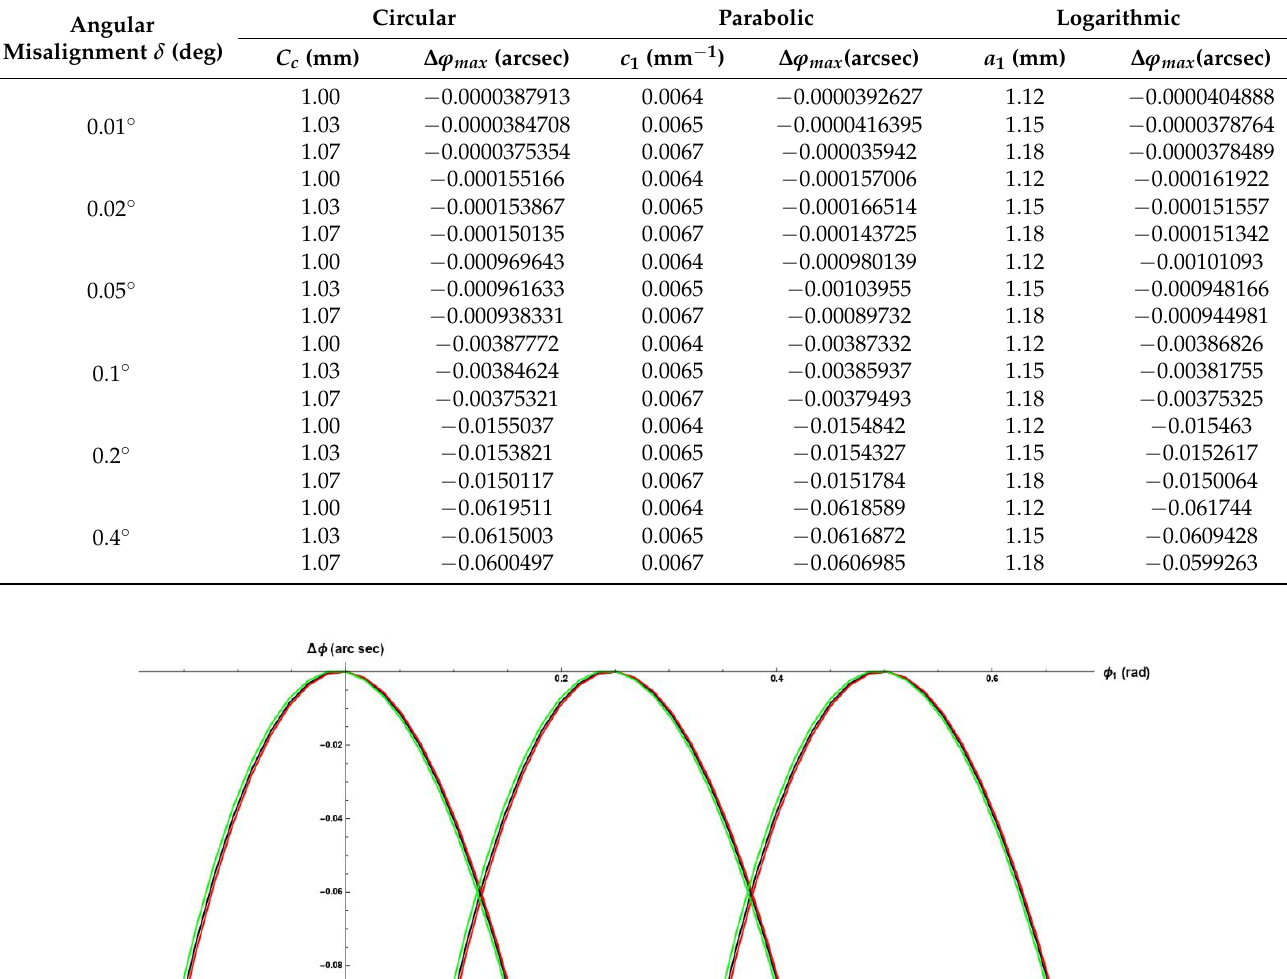
Table 3. Amount of modifications relative to out-of-plane angular misalignment for spur gears engagement.